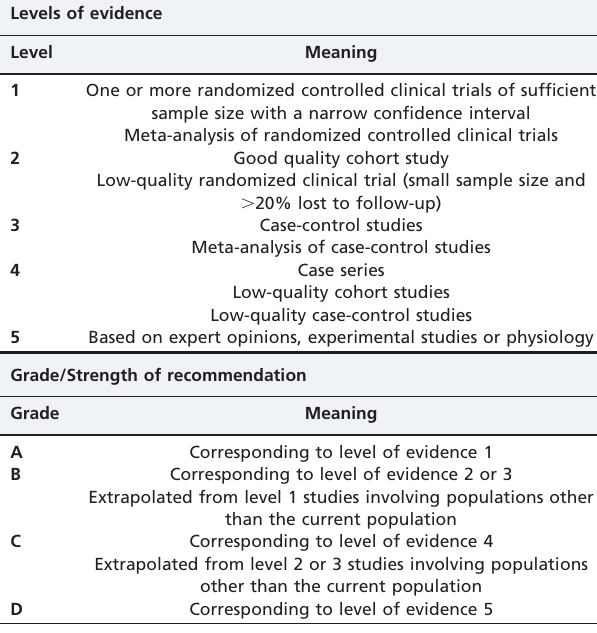
Table 5 - Evidence levels and degrees of recommendation for